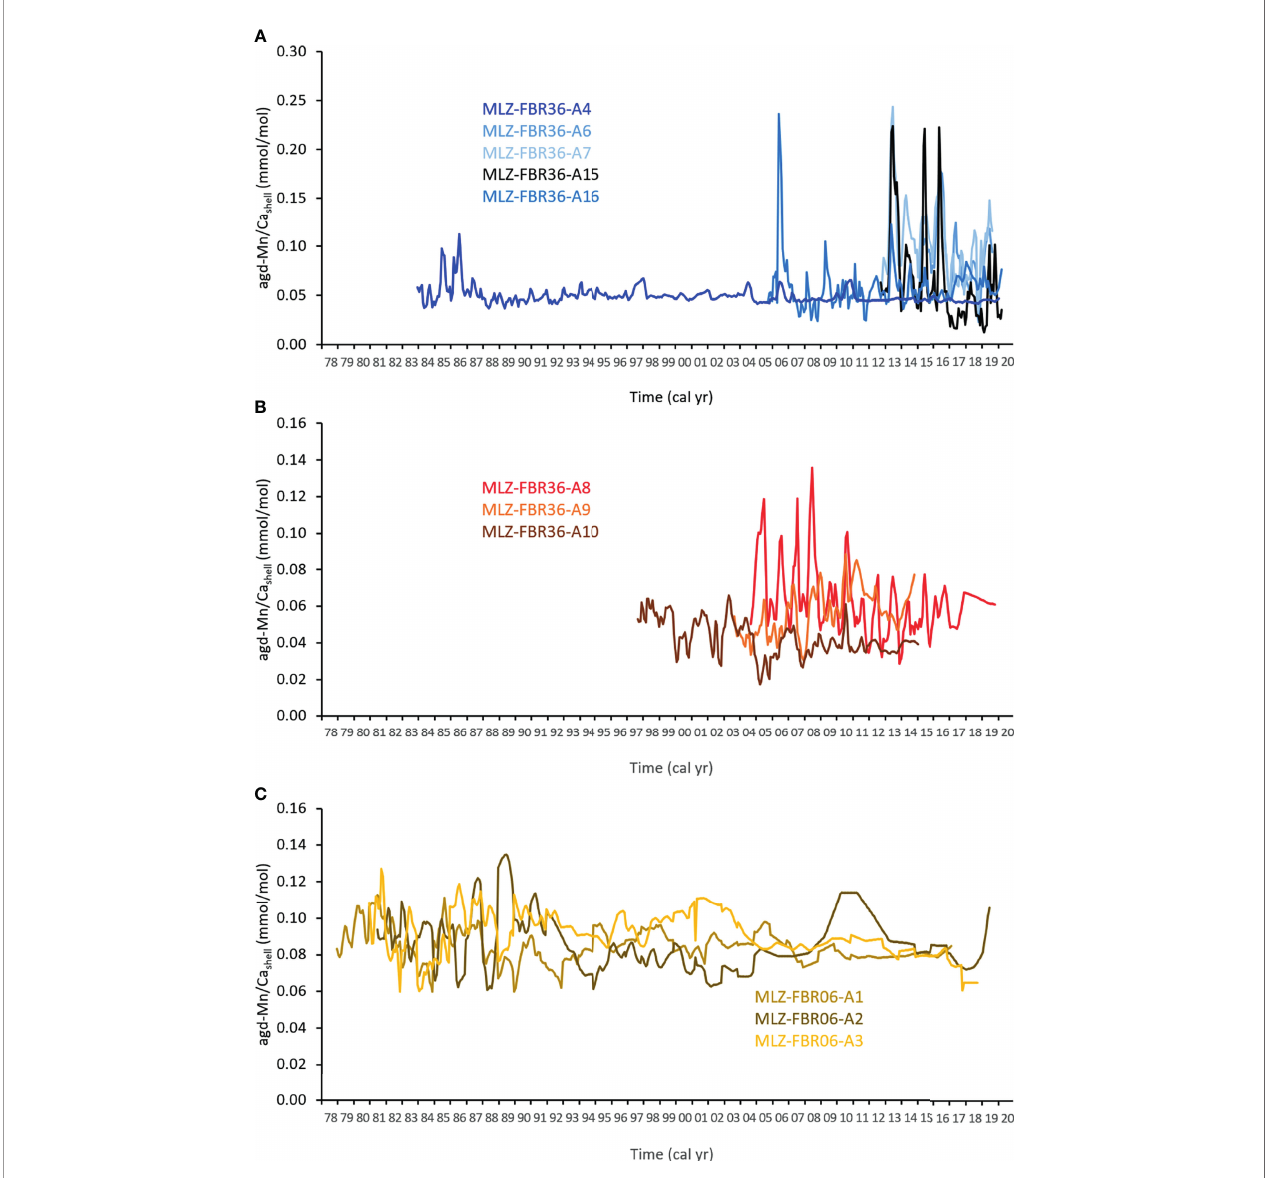
FIGURE 9 | After removal of annual growth rate-related trends (compare Figures 8A – C ), Mn/Ca shell chronologies (monthly resolution; agd, annual growth rate detrended) plotted closer together and revealed a larger degree of running similarity. (A) A. islandica ; (B) A. elliptica ; (C) A. borealis